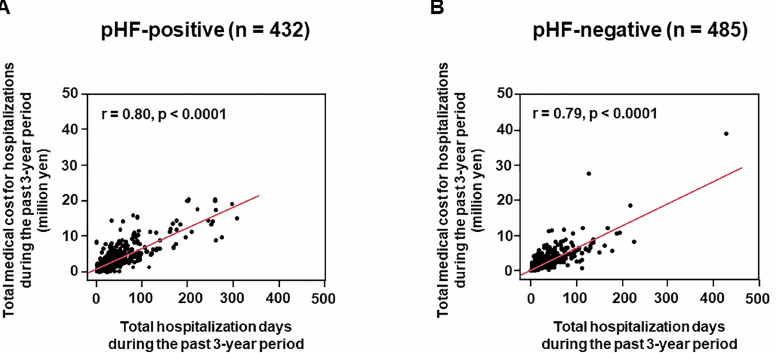
Fig 2. Correlation of total medical cost for all-cause hospitalizations with total hospitalization days during the past 3-year period. In both the possible heart failure (pHF)-positive (A) and negative patients (B), there was a positive strong correlation between total medical cost and hospitalization